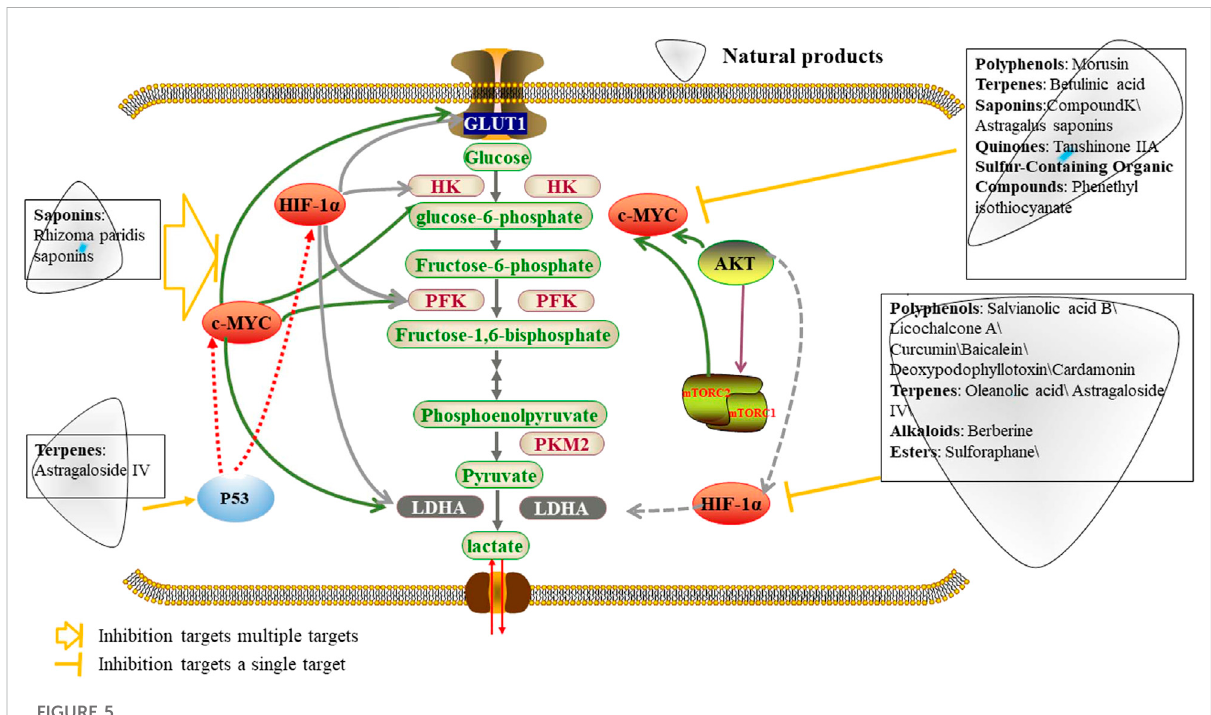
FIGURE 5 Natural products inhibit aerobic glycolysis by targeting